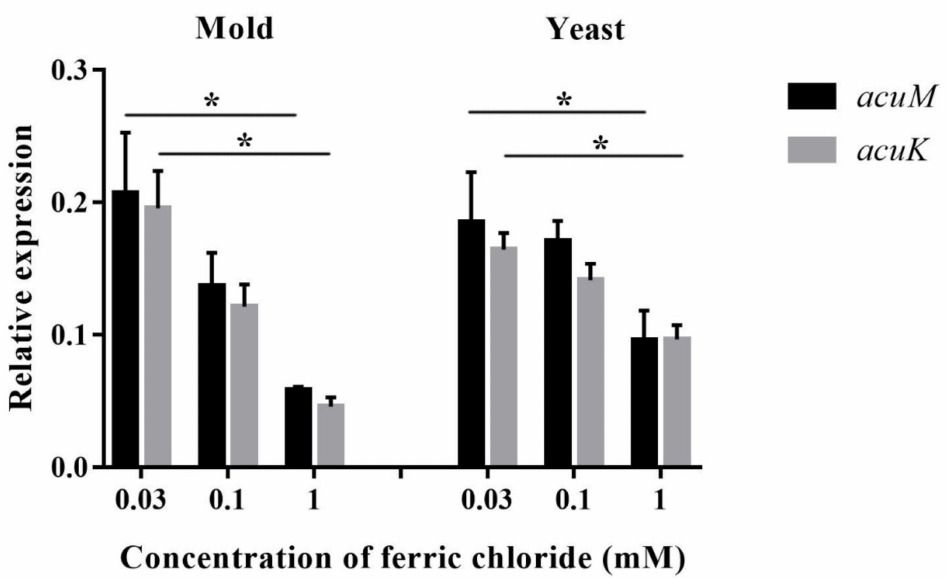
Figure 6. Relative expression levels of acuM and acuK during growth in various concentrations of iron. T. marne ff ei was cultured in the glucose minimal medium containing ferric chloride at di ff erent concentrations at 25 ◦ C for 36 h (mold) or 37 ◦ C for 60 h (yeast). An asterisk indicates a significant di ff erence ( p < 0.05) when compared to the respective gene at 0.03 mM iron